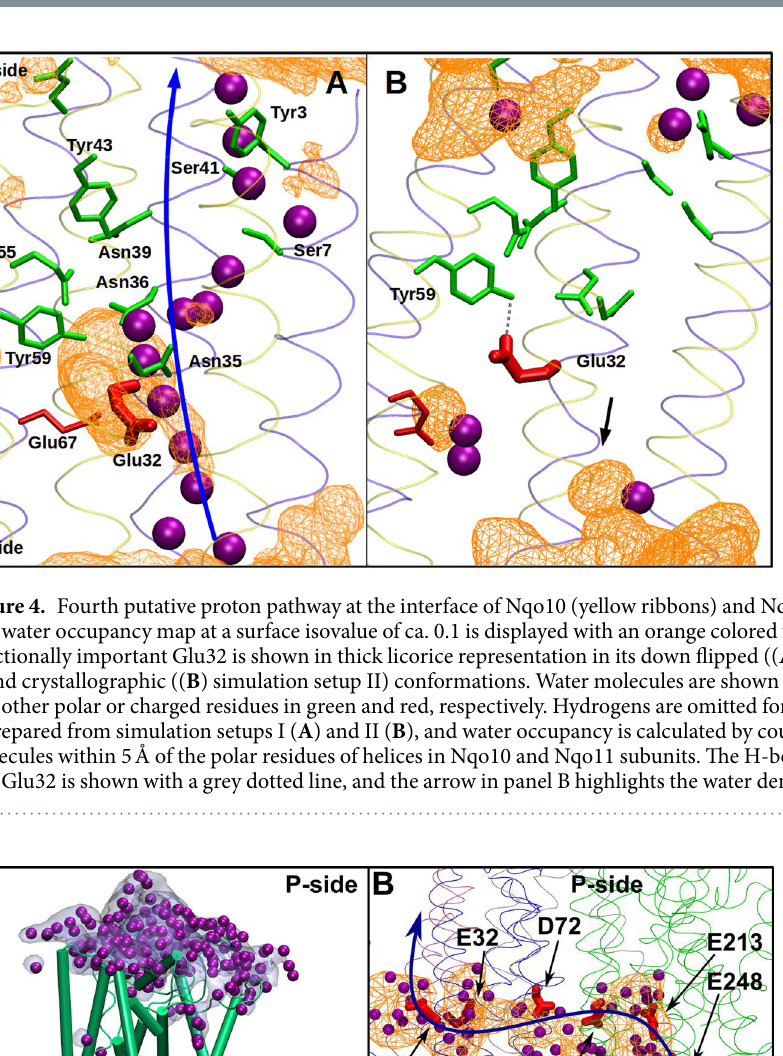
the membrane-bound subunits, as observed from simulation data, is critical for the proton pumping function of the enzyme (see below). Hydration and dynamics of Nqo4 and Nqo6 subunits. The two subunits Nqo4 and Nqo6 form the scaffold for the Q-binding close to the N2 FeS center 18, 19 . Due to the presence of multiple charged residues in Nqo4, water molecules rapidly hydrate the subunit (Figs 2, 6 and Supplementary S10), also including the region around the Q head group. This raises an important question that what prevents the protonation of the residues that are left deprotonated after the proton-coupled electron transfer to Q from N2 30 . In an earlier work, a partial stabilization of the anionic Tyr87 by neutral His38 of Nqo4 was observed 30 . However, deprotonated Tyr87 is likely